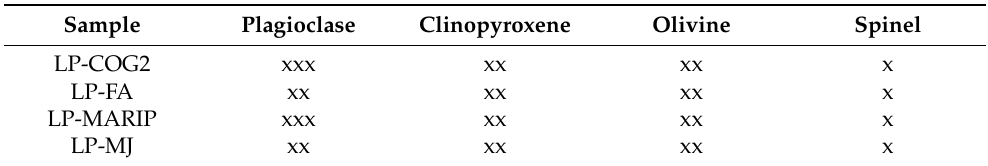
Table 2. Semi-quantitative abundance estimations: xxx = very abundant (>40%); xx = major (10–40%); x = minor